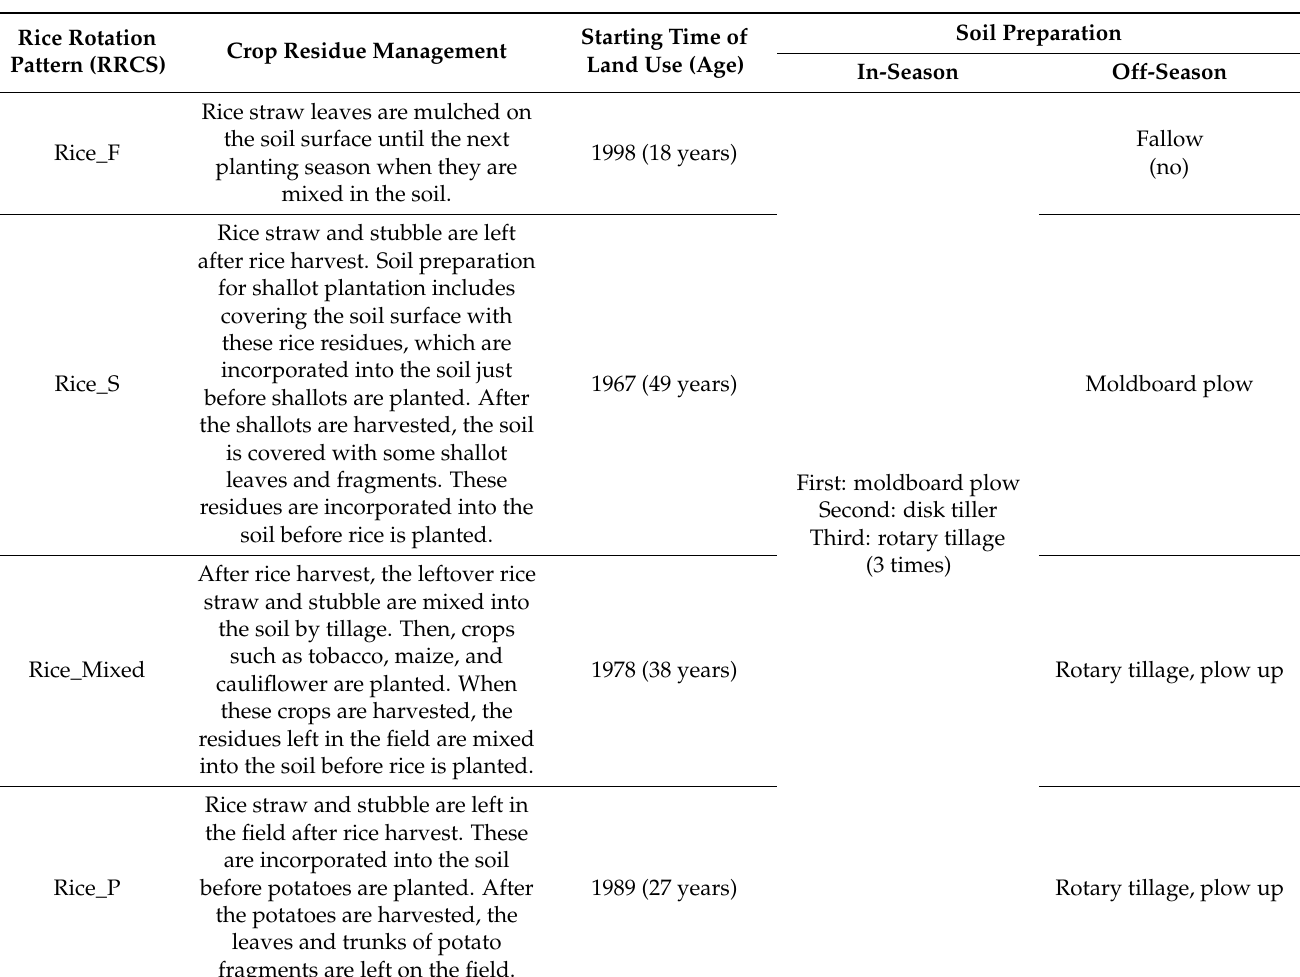
Table 1. Crop residue management, age of land use, and tillage intensity of the